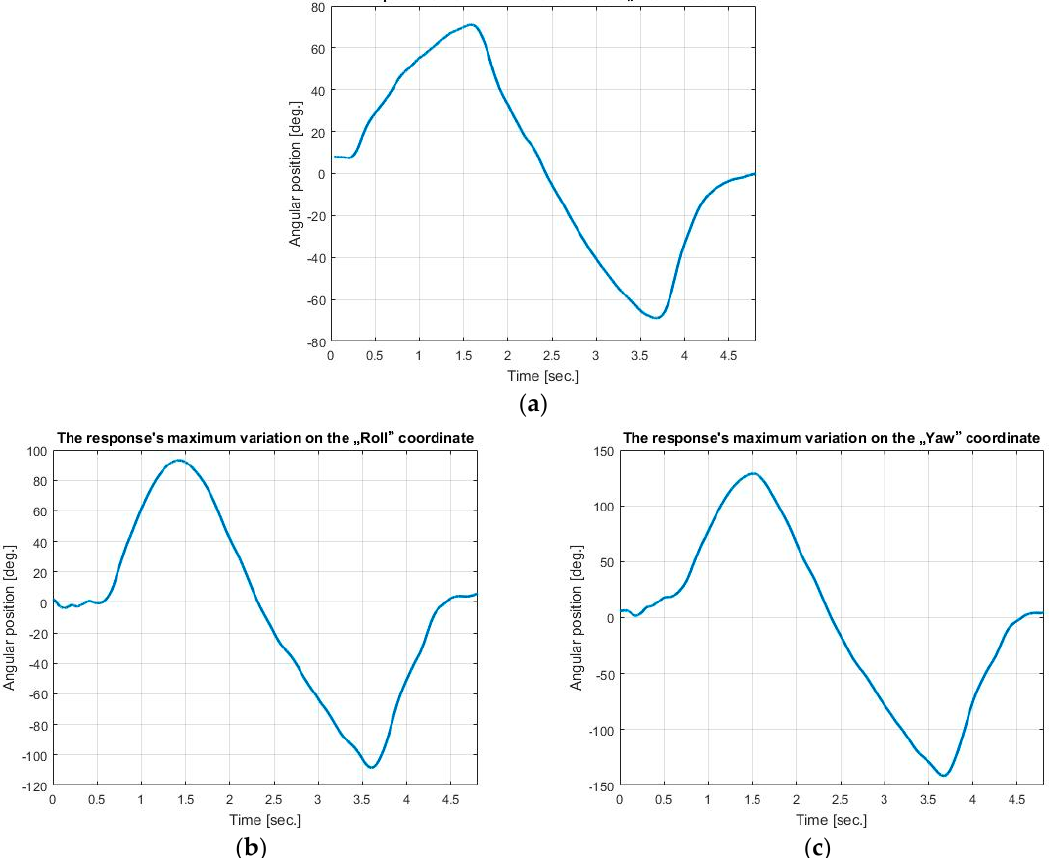
Figure 10. Measured output for the three degree of freedom: ( a ) pitch; ( b ) roll; ( c ) yaw.